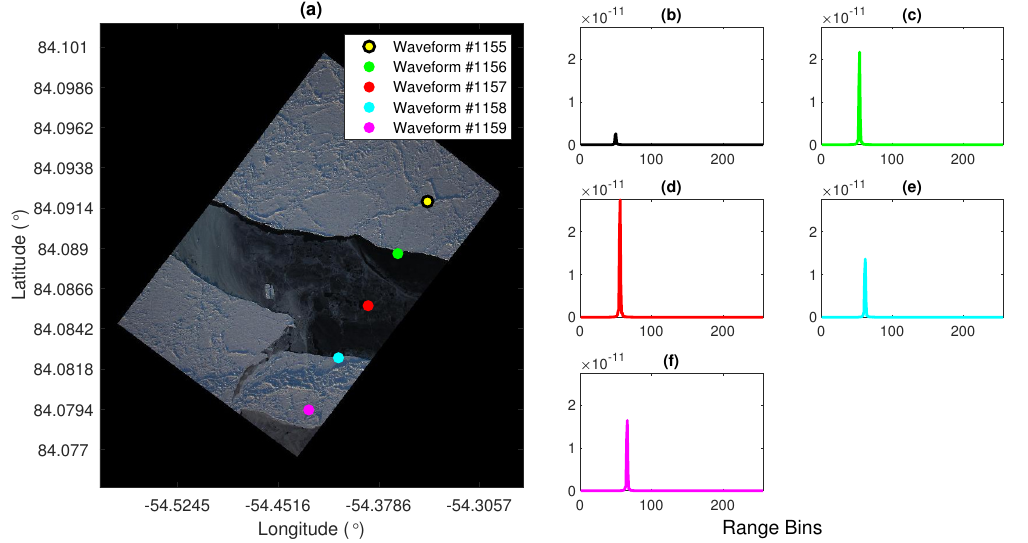
Figure 6. CS-2 descending track #15632 (taken on 20 March 2013) showing five waveform surface sample locations ( a ). Image is acquired at 17:03:15 GPS time, approximately 30 min before satellite overpass. Waveforms associated with the locations are also shown. ( b ) is waveform #1155; ( c ) #1156; ( d ) #1157; ( e ) #1158 and ( f ) #1159.